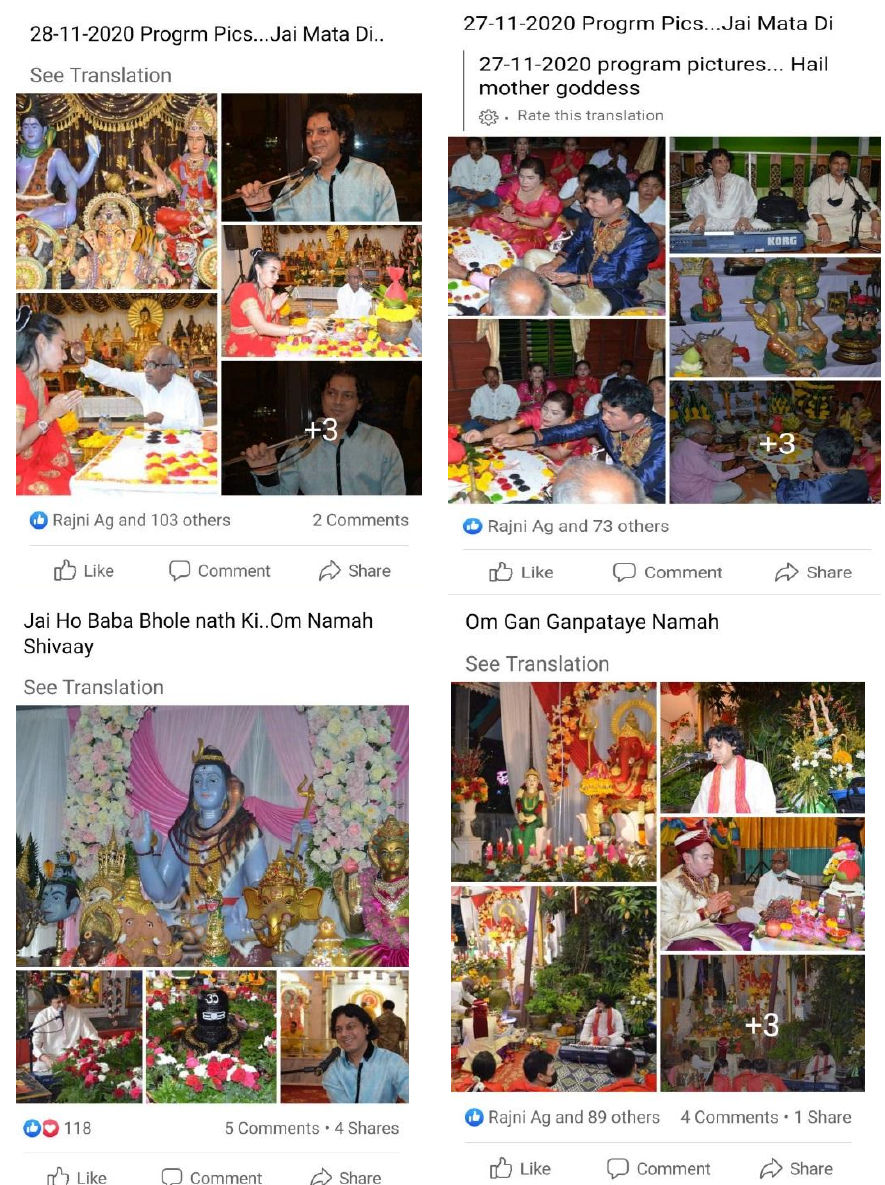
Figure 1. Images show, left–right, top–bottom: Blessing newborn baby, posted on 22 January 2019. Installing a new Ganesa image in Rangsit area, posted on 13 February 2019. Conducting the cere- mony for a shop selling religious icons in Imperial Mall in Ladprao area, posted on 15 February 2019. With devotees at a beauty clinic after performing pooja at their clinic in Bangkok, posted on 27 February 2019 (Images used with permission).